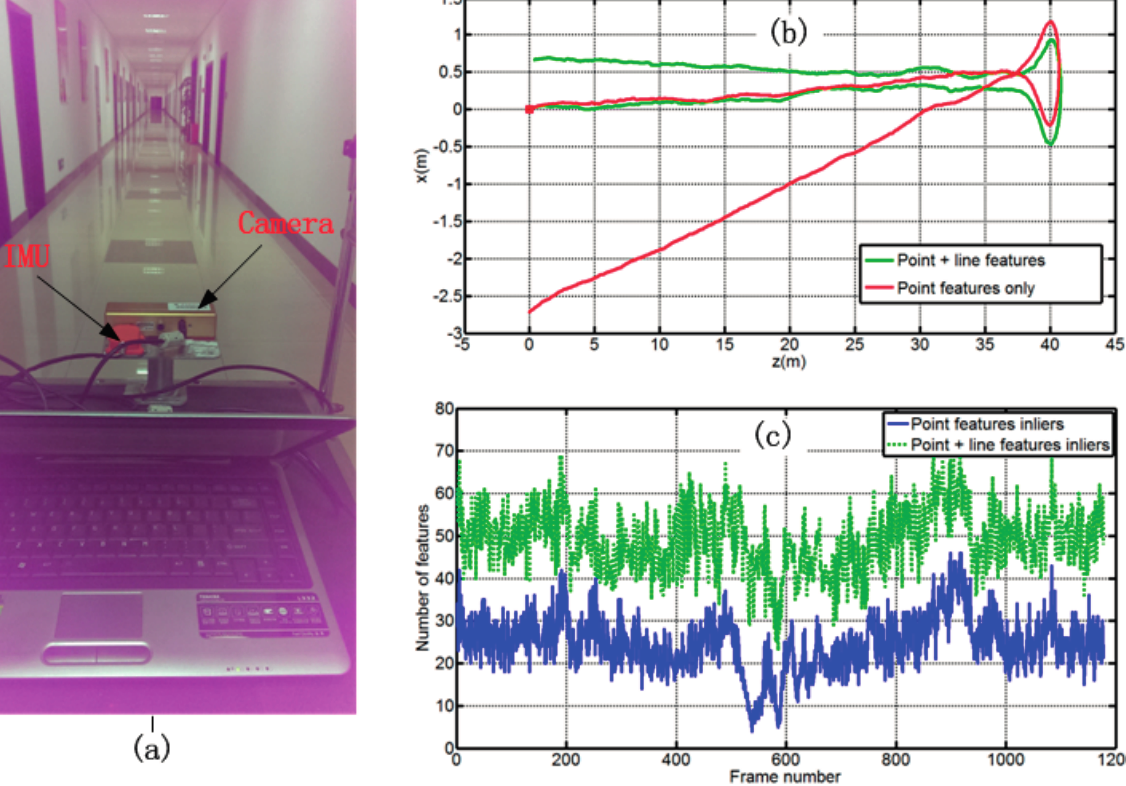
Figure 8. Performance in low-textured indoor environment: ( a ) Experimental setup and experimental scene; ( b ) Top view of estimated trajectories; ( c ) The number of point and line inliers used to estimate the